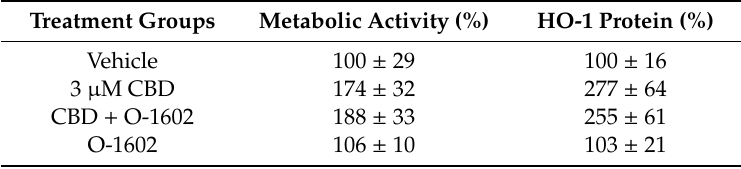
Table 2. Involvement of GPR55 in the changes in metabolic activity and HO-1 expression triggered by CBD. The cells were pre-treated for 1 h with O-1602 at 1 µ M before CBD (3 µ M) or vehicle was added. Subsequently, the incubation was continued for 24 h. Afterwards, the cells were evaluated with respect to their metabolic activity by WST-1 assay or for the expression of HO-1 by Western blot. Protein expression values were normalized to β -actin. The percentage control represents a comparison with the cells treated with vehicle (set to 100%) in the absence of test substance. The data represent mean values ± SEM of n = 3 di ff erent donors. Statistical significances were excluded by one-way ANOVA with Bonferroni´s post hoc